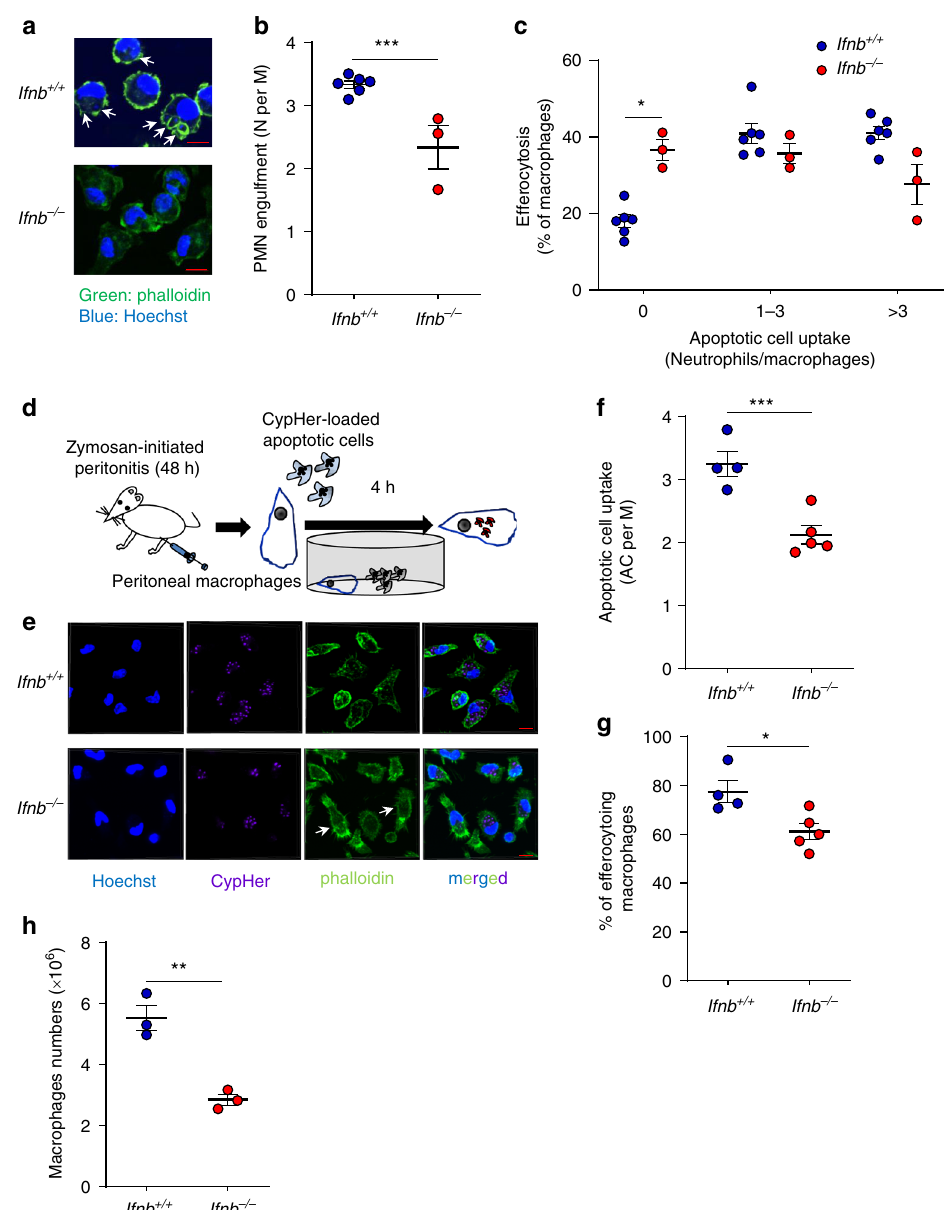
Fig. 6 IFN- β enhances macrophage efferocytosis during the resolution of in fl ammation. a – c Peritoneal macrophages were recovered from male Ifnb + / + or Ifnb − / − mice at 48 h PPI and stained with Hoechst 33342 and FITC-phalloidin ( a ). Fluorescent images of select frames were taken using high-resolution microscopy achieved by 3D confocal (z-stack) scanning with a Nikon A1-R confocal fl uorescent microscope. The number of apoptotic PMN nuclei in each macrophage were enumerated (see arrowheads for illustration) using the Nikon NIS-Elements microscope imaging software and average engulfment per macrophage ( b ) or engulfment according to thresholds ( c ) were calculated. Representative images ( a ) and means± SEM ( b , c ) for six ( Ifnb + / + ) and three ( Ifnb − / − ) experiments. d – f Peritoneal macrophages were recovered from male Ifnb + / + or Ifnb − / − mice at 48 h PPI and incubated with CypHer-labeled apoptotic Jurkat cells at a ratio of 1:3. After 4 h, unbound cells were washed and macrophages were stained with Hoechst 33342 and FITC-phalloidin (as illustrated in d ). Select images of each staining and merged images are shown ( e ). The number of engulfed apoptotic cells (AC) in each macrophage (M) were counted and average apoptotic cell uptake ( f ) and the percentage of efferocytosing macrophages ( g ) were calculated. h The total numbers of F4/80 + peritoneal macrophages was detected by fl ow cytometry and calculated. Representative images ( e ) and means ± SEM ( f – g ) for four ( Ifnb + / + ) and fi ve ( Ifnb − / − ) independent experiments. * P < 0.05, *** P < 0.005 (Student ’ s t test). Source data are provided as a Source Data fi reduced expression of the genes coding for the efferocytic CD45 expression was unaffected (Fig. 9k – l). This expression receptors Mertk and CD206 with slight decreases in CD36 in pro fi le resembles that of eosinophils that are non-phagocytic cells non-phagocytic macrophages (6.7, 2.03, and 1.46 fold reduction, (Fig. 9l). Thus, macrophage loss of phagocytosis seems to be a respectively). Consistently, we detected signi fi cantly lower surface progressive and irreversible process in vivo and is associated with expression of all three efferocytic receptors (57%, 64%, and 49% reduced expression of efferocytic receptors through transcrip- reduction for CD36, CD206, and Mertk, respectively) whereas tional and none-transcriptional mechanisms.